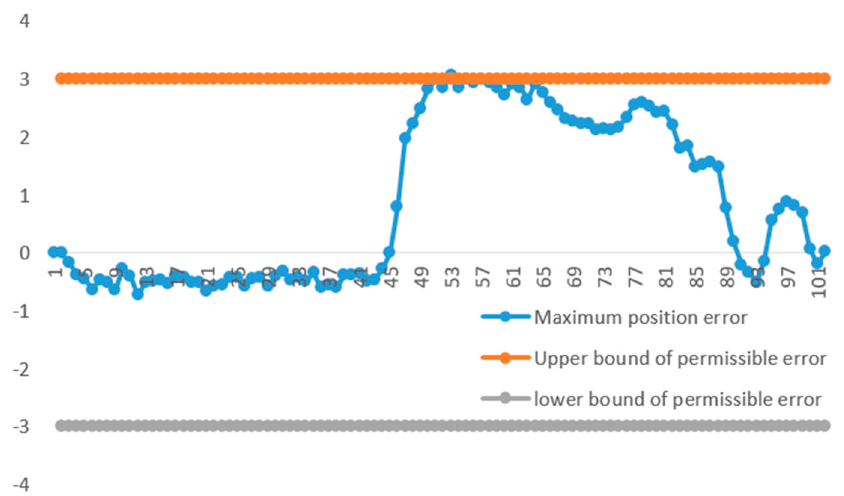
Figure 17. Position error of each trajectory point in the z-direction.